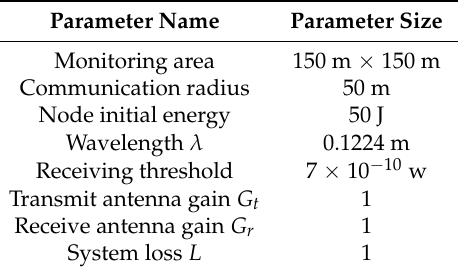
Table 1. Experimental